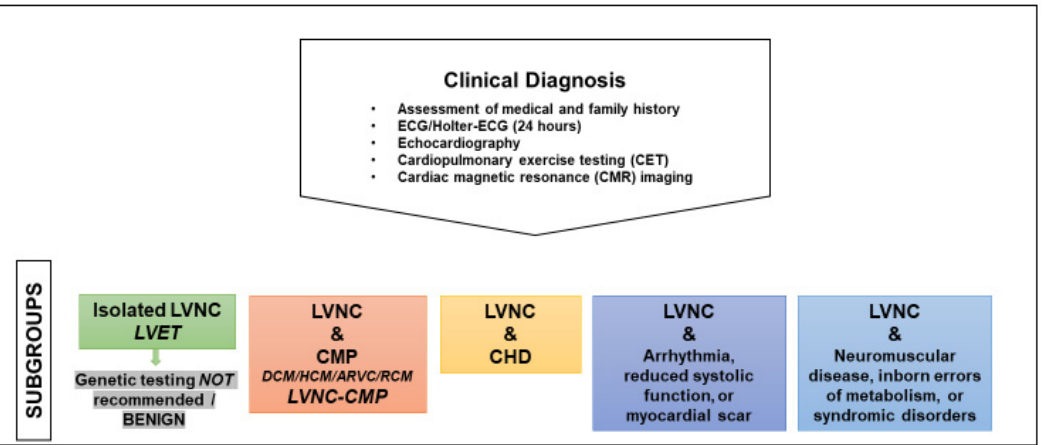
Figure 1. Clinical diagnosis and subgroups in pediatric LVNC. ARVC, arrhythmogenic right ven- tricular cardiomyopathy; CHD, congenital heart defects; CMP, cardiomyopathy; DCM, dilated cardiomyopathy; HCM, hypertrophic cardiomyopathy; ECG, electrocardiogram; LVET, left ventricular excessive trabeculation; LVNC, left ventricular noncompaction; LVNC-CMP, left ventricular noncompaction cardiomyopathy; RCM, restrictive cardiomyopathy.